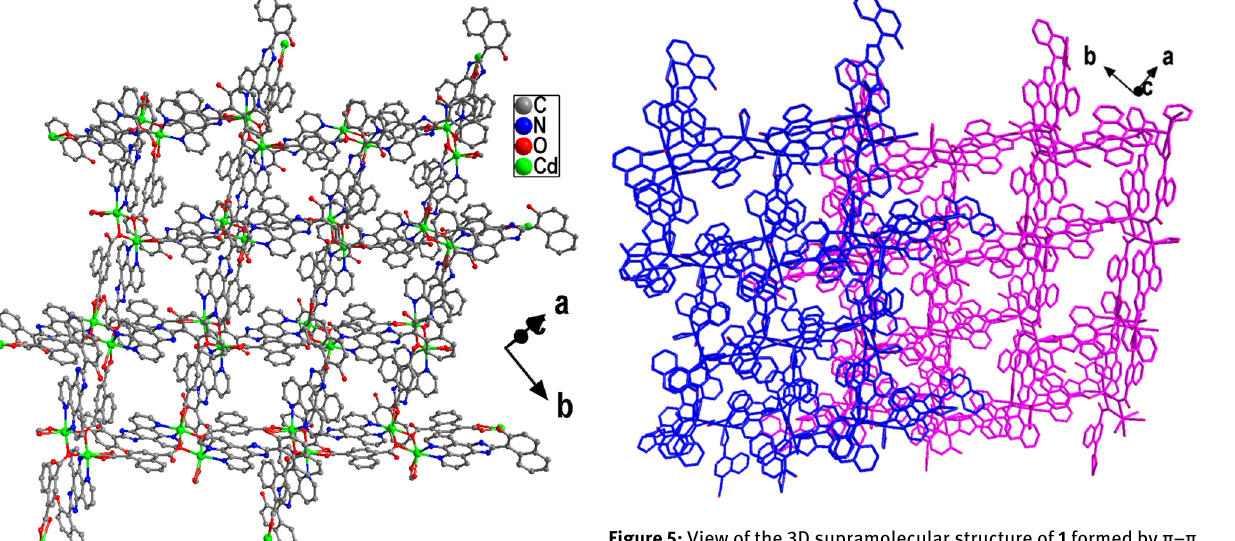
Figure 5: View of the 3D supramolecular structure of 1 formed by π – π interactions.